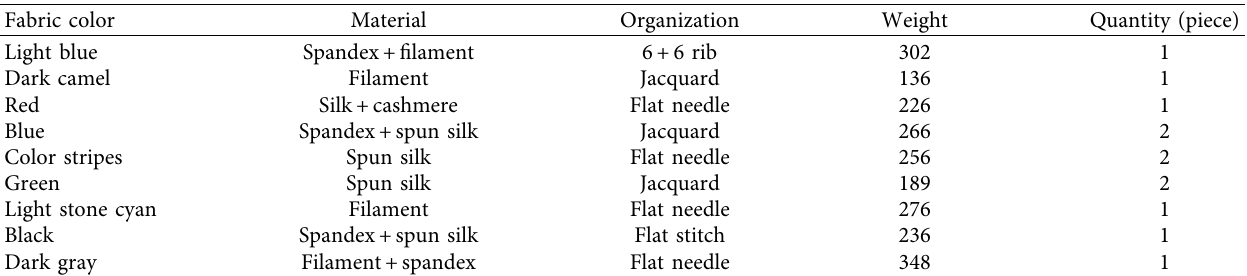
Table 7: Different clothing